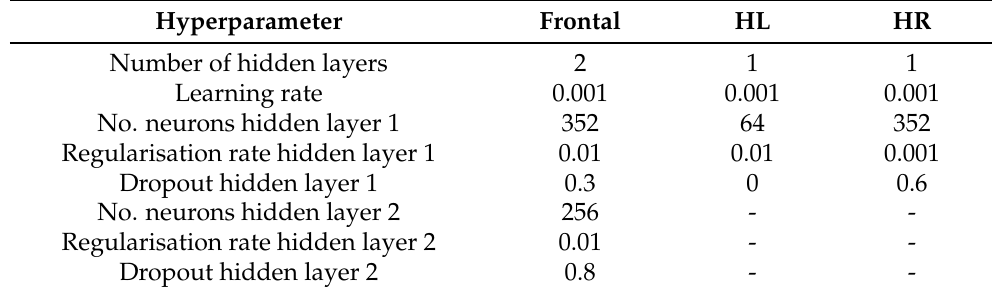
Table A1. Final configurations of the DNN models after splitting on pose, finding the best feature subset using feature selection and hyperparameter tuning. HL: Half Left, HR: Half